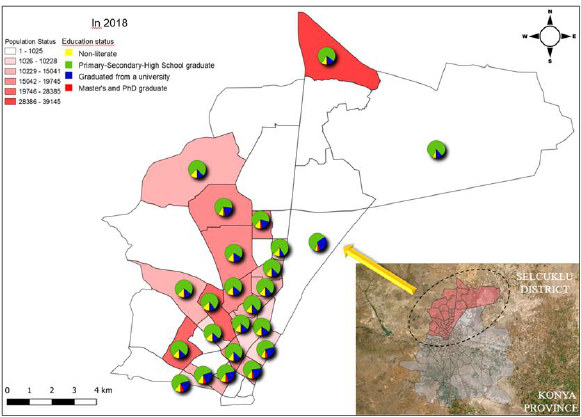
Figure 6. Spatial distribution of demographic data for 2018